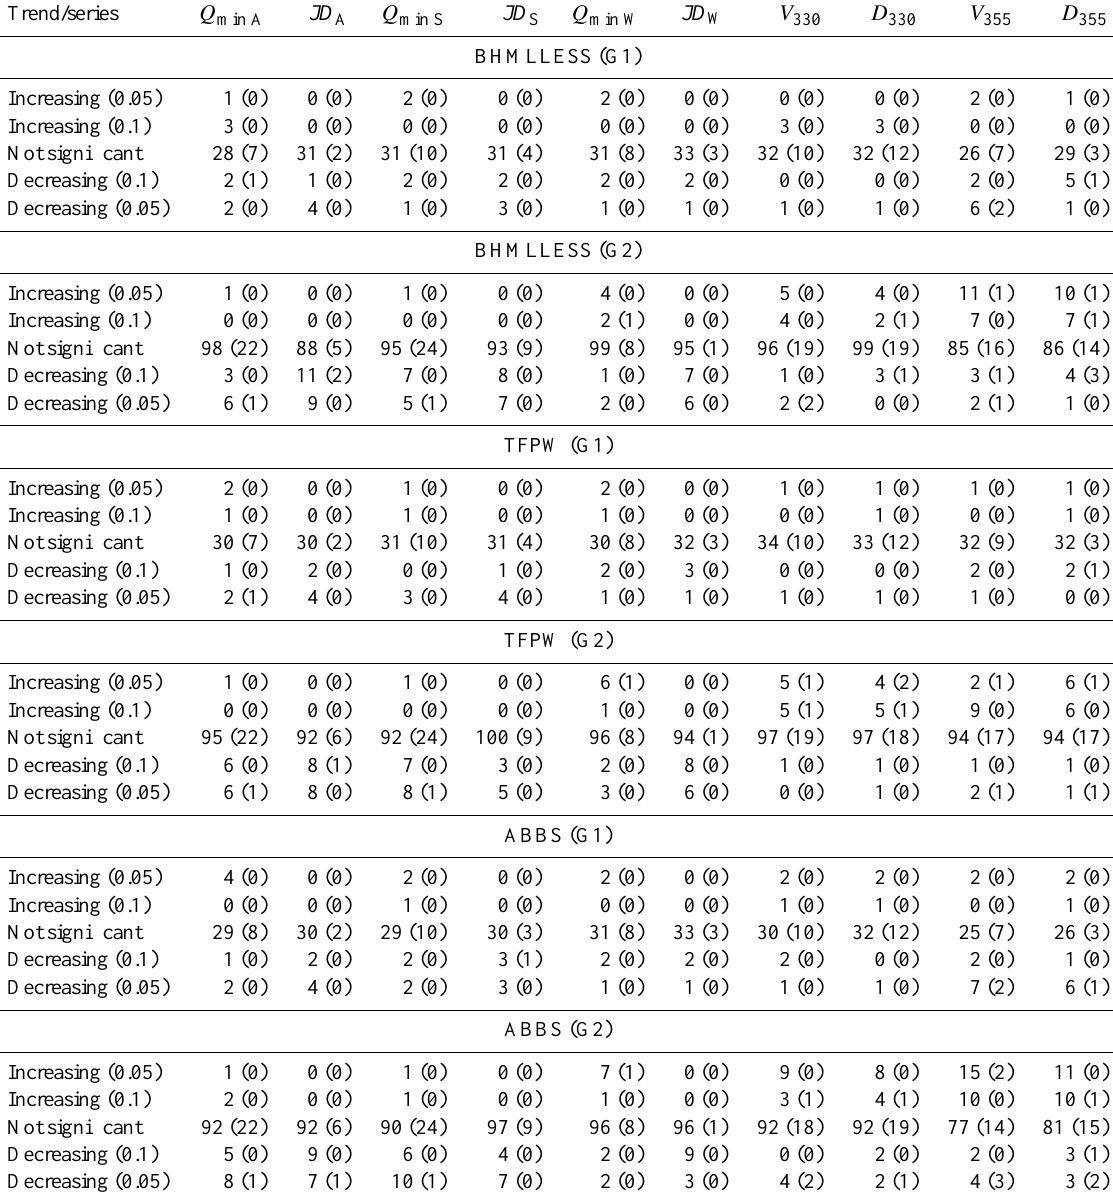
Table 1. Numbers of significant trends in drought-related series in Czechia during the period 1961–2005 according to various modifications of the Mann–Kendall test at the 0.1 and 0.05 levels. Figures in parentheses refer to the numbers associated with Hurst exponents significant at α = 0.05. For series designations see Sect.